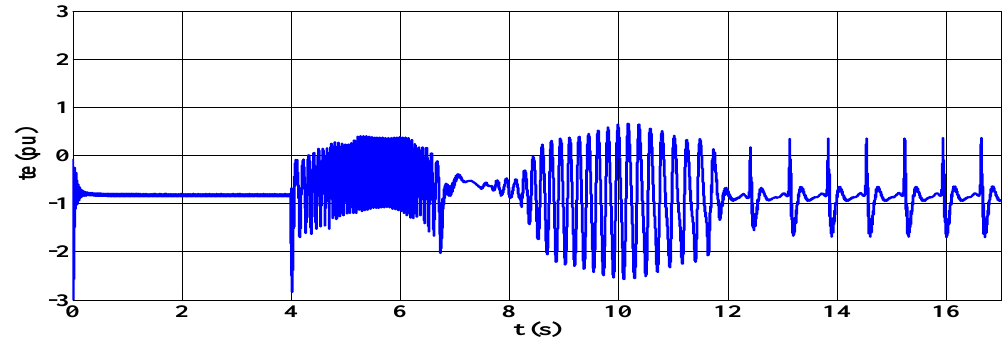
Figure 7. Electromagnetic torque (short-circuit happens at t = 4